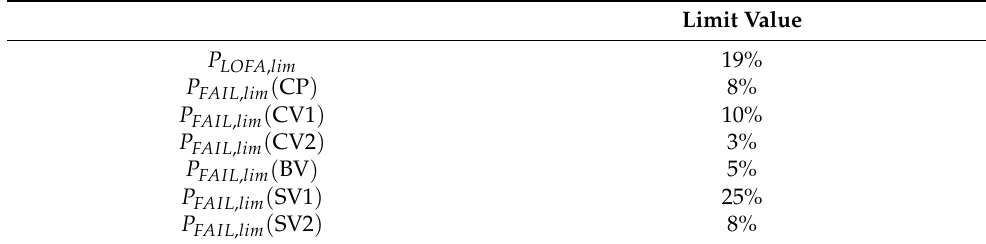
Table 1. Optimal values of P LOFA , lim and P FAIL , lim ( e ) .